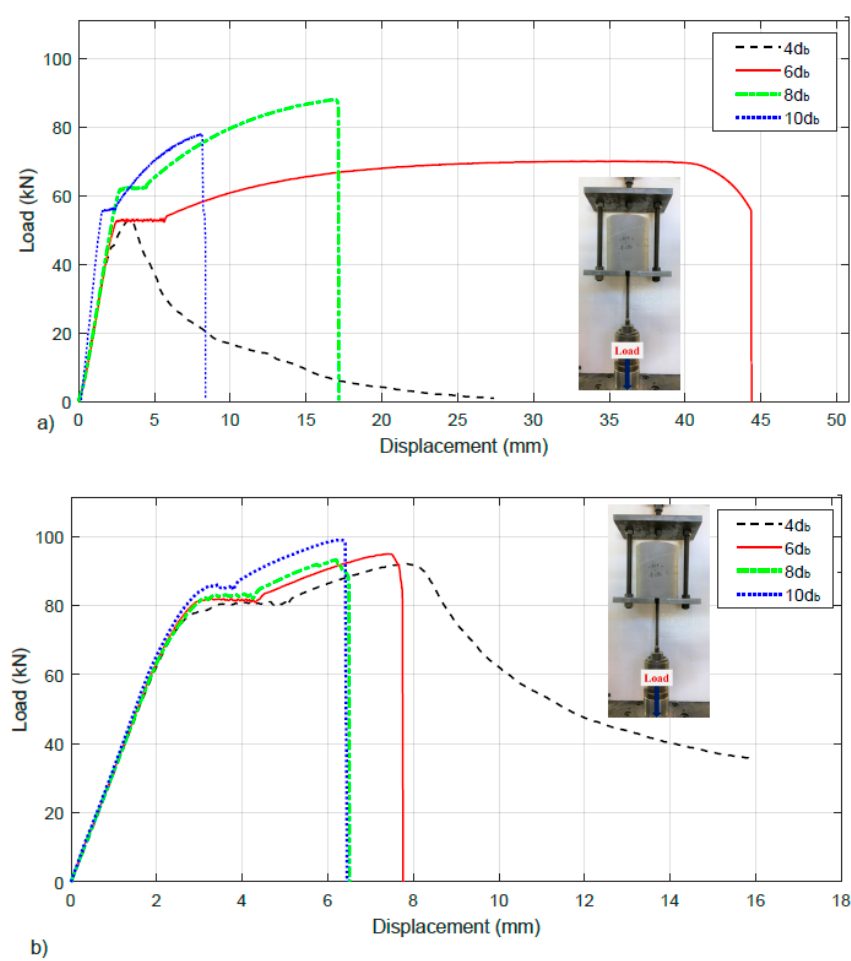
Figure 5. Median load-displacement curve for pull-out test: ( a ) #13 (12.7 mm) rebar for all four embedment lengths; ( b ) #16 (15.9 mm) rebar for all four embedment lengths.